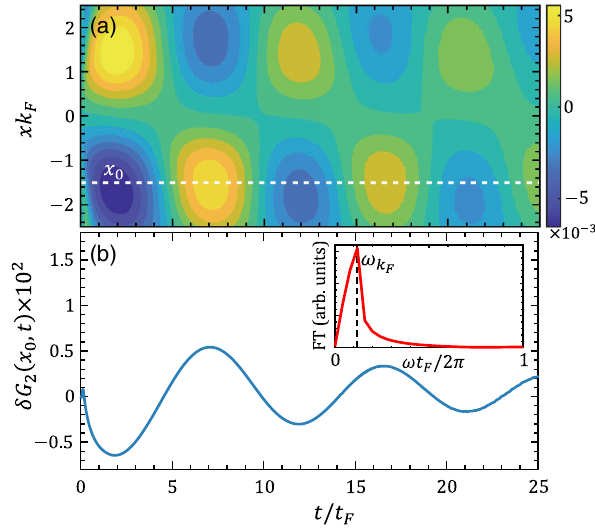
FIG. 2. Linear-response dynamics in the impurity frame after a soft quench of the coupling strength γ : from γ ¼ 6 to γ ¼ 5 . The wave function at t ¼ 0 corresponds to the ground state at Q ¼ k F and γ ¼ 6 . (a) Evolution of δ G 2 ð x; t Þ ¼ G 2 ð x; t Þ − G 2 ð x; 0 Þ showing oscillatory behavior of the fermionic density surround- ing the impurity. (b) Dynamics of δ G 2 ð x; t Þ at x ¼ x 0 [dashed line in (a)]. Notably, the Fourier transform of this signal (inset) matches the frequency ω extracted from Fig. 1(b). k F